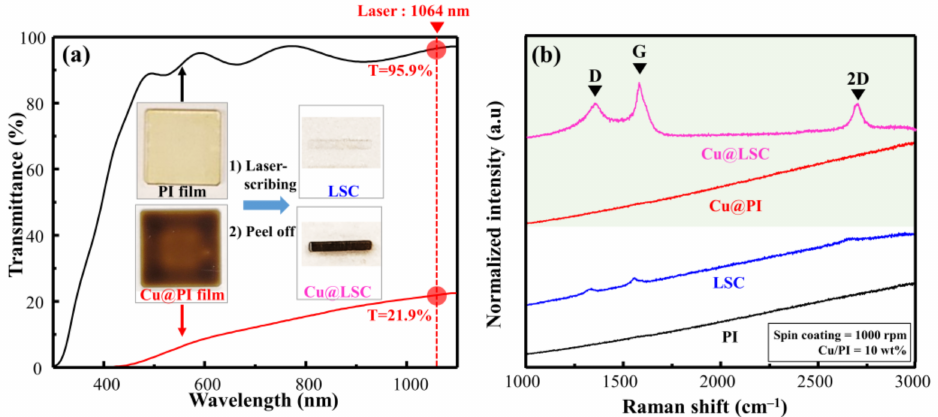
Figure 2. ( a ) VisNIR spectra and photographs, and ( b ) Raman spectra of spin-coated raw PI and Cu@PI film with laser